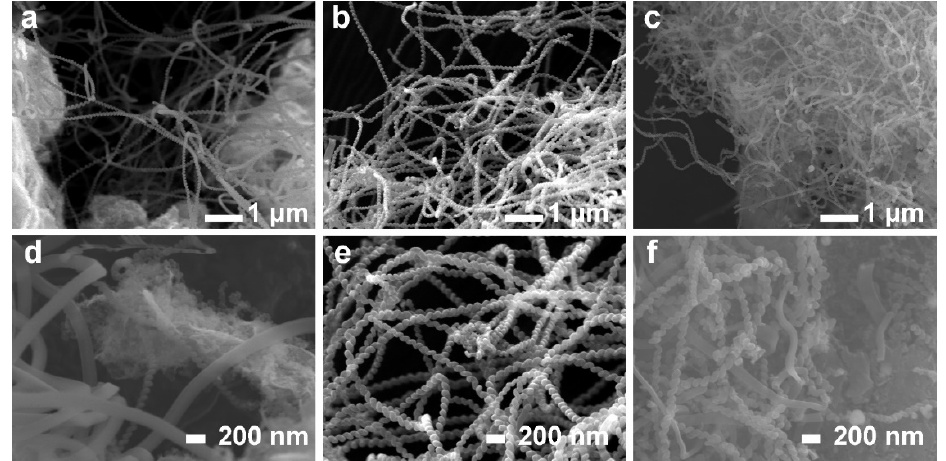
Figure 4. SEM images for CNCs. ( a , d ) CNCs synthesized by Cu100, ( b , e ) CNCs synthesized by Cu200, ( c , f ) CNCs synthesized by Cu 400.